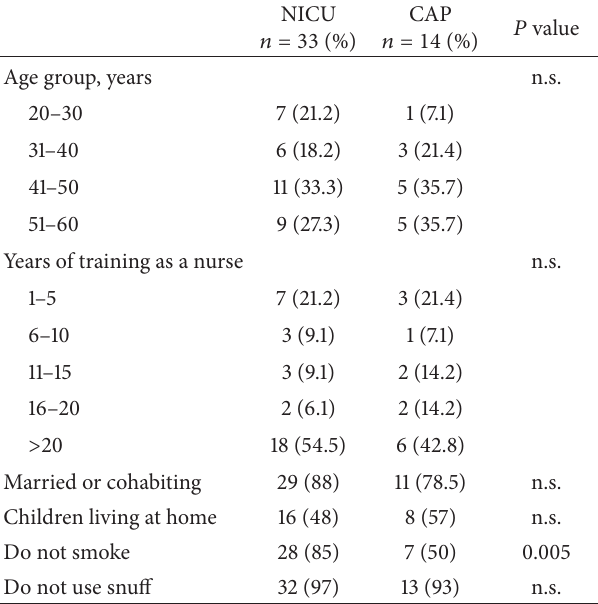
Table1:Demographicanddescriptivecharacteristicsofnursesfrom theneonatalintensivecareunit(NICU)andthechildandadolescent psychiatry inpatient ward (CAP), respectively.